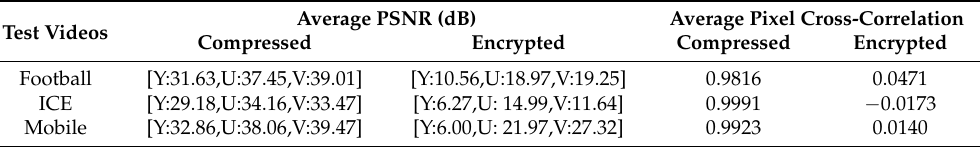
Table 6. Comparison of average peak signal to noise ratio (PSNR) (dB) and pixel cross-correlation of SE at QP = 36 with EXPer for the videos encoded with CABAC.